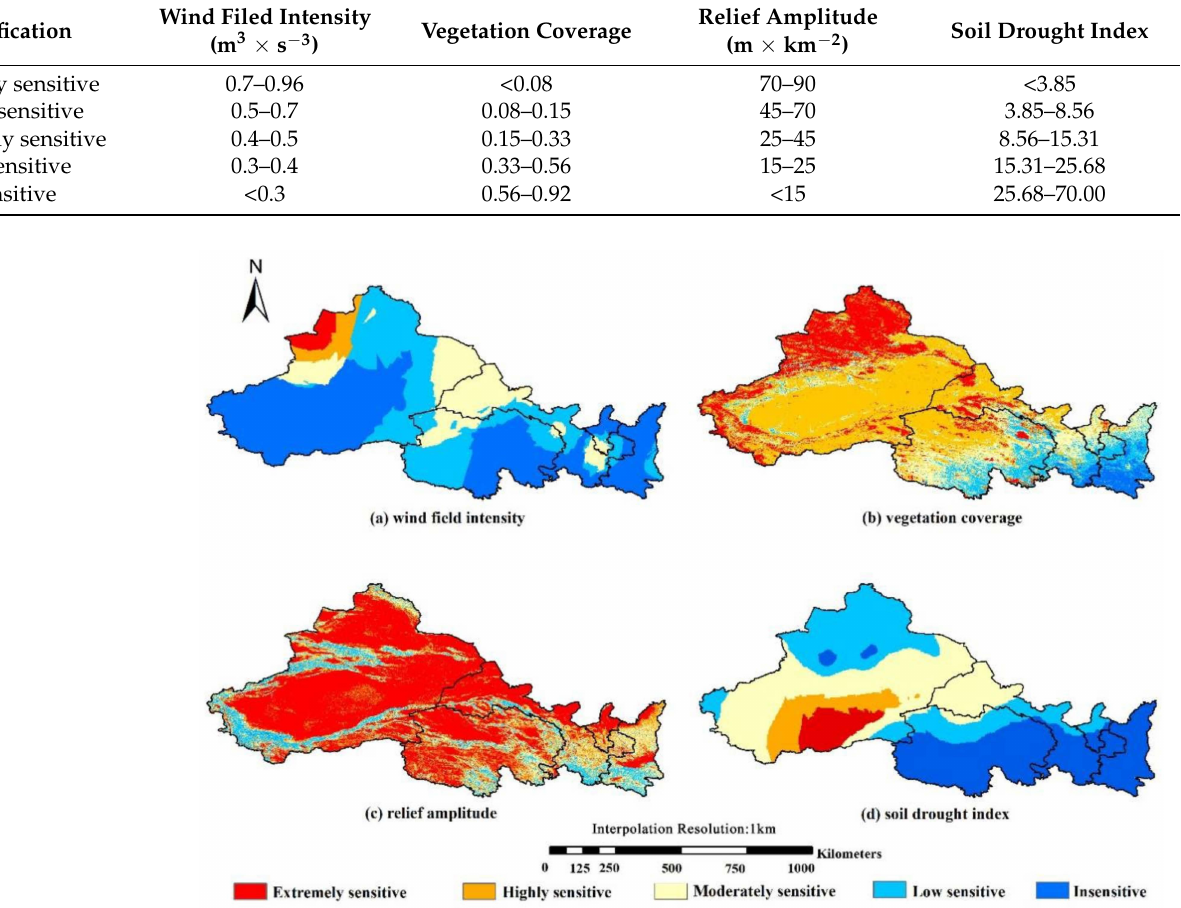
Figure 8. Results of sensitivity analysis of wind erosion factors (annual values of wind field intensity, vegetation coverage, relief amplitude, and soil drought index for